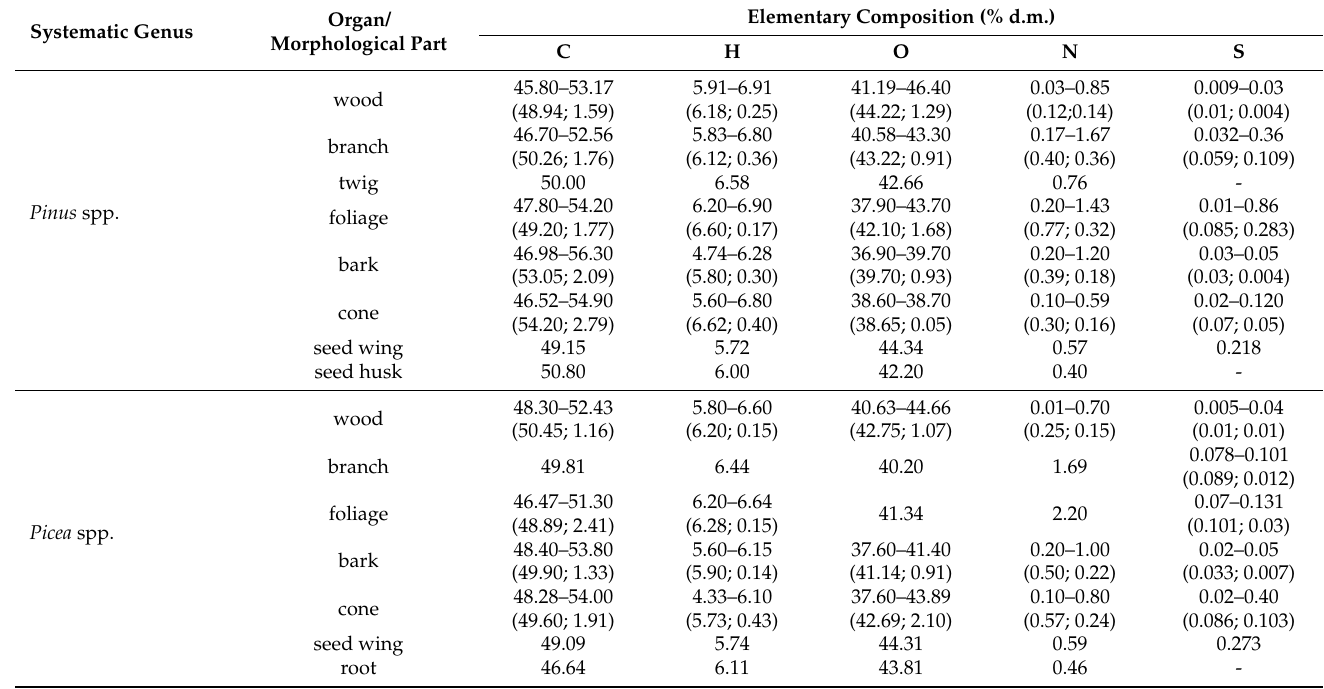
Table A2. Elementary composition/ultimate analyses of particular organs of various systematic genera of